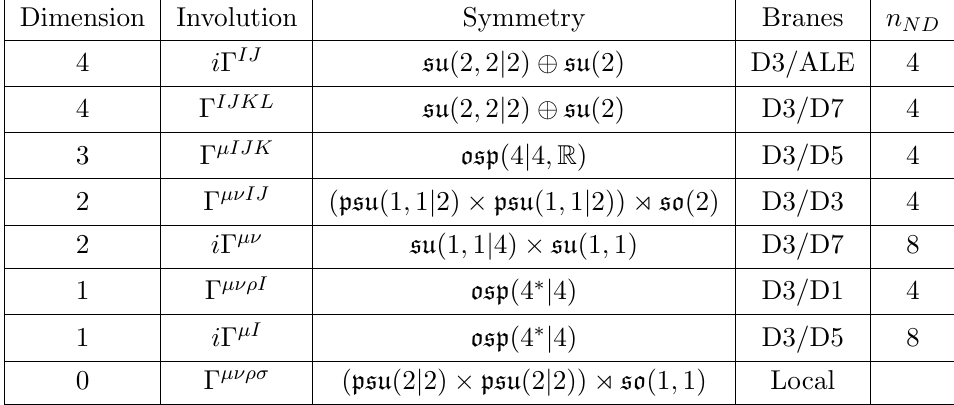
Table 1 . Half-BPS subalgebras of psu (2 ; 2 j 4) (cid:12)xed by involutions, and realizations by IIB